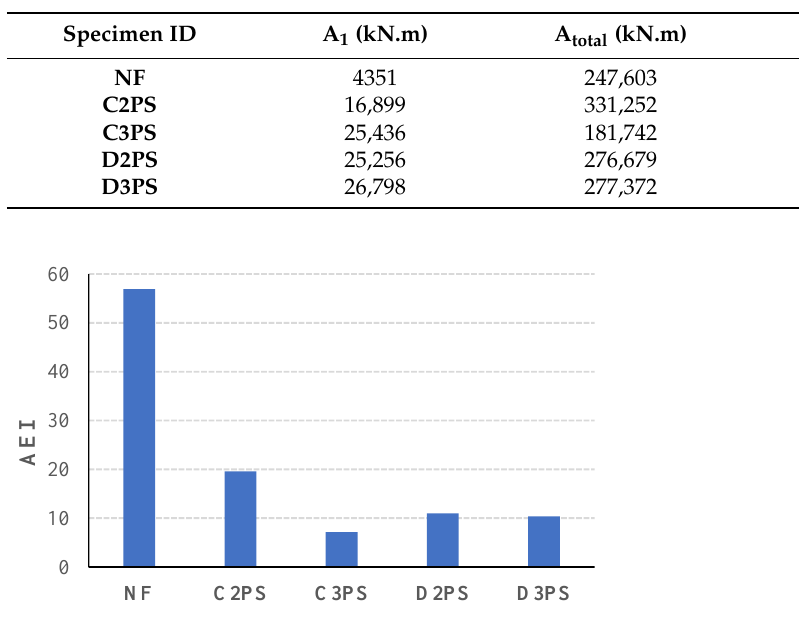
Figure 14. Absorbed energy index for tested specimens. Table 7. Absorbed energy index for all tested specimens.